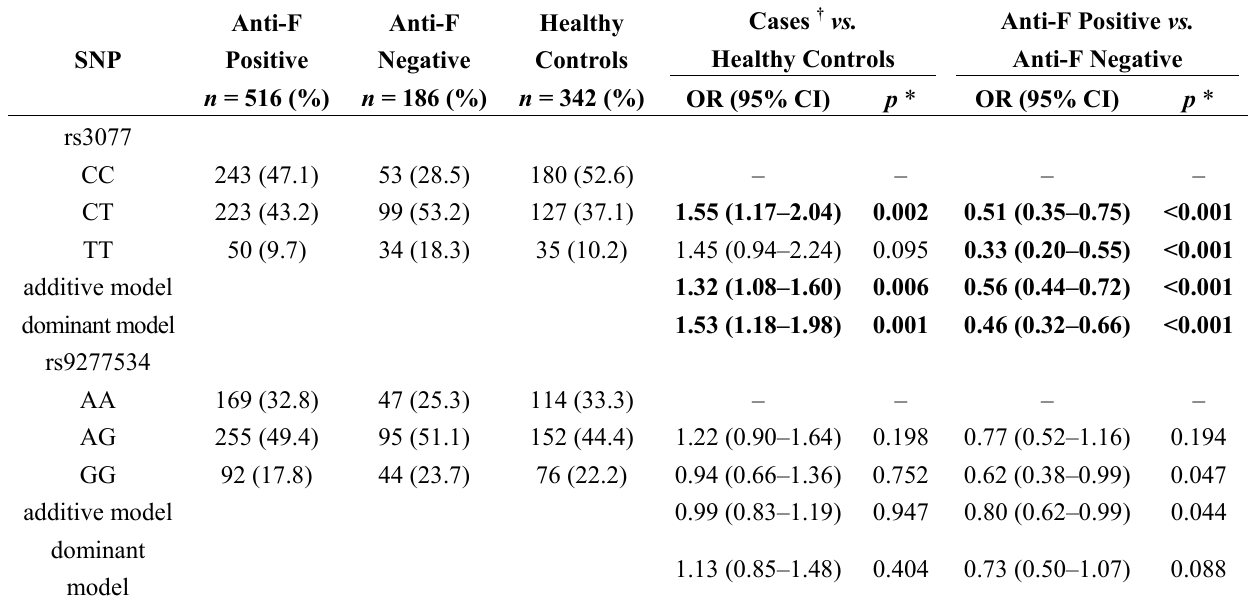
Table 2. Genotype distribution and association of rs3077 and rs9277534 with risk of chronic HCV infection and anti-F antibody generation.